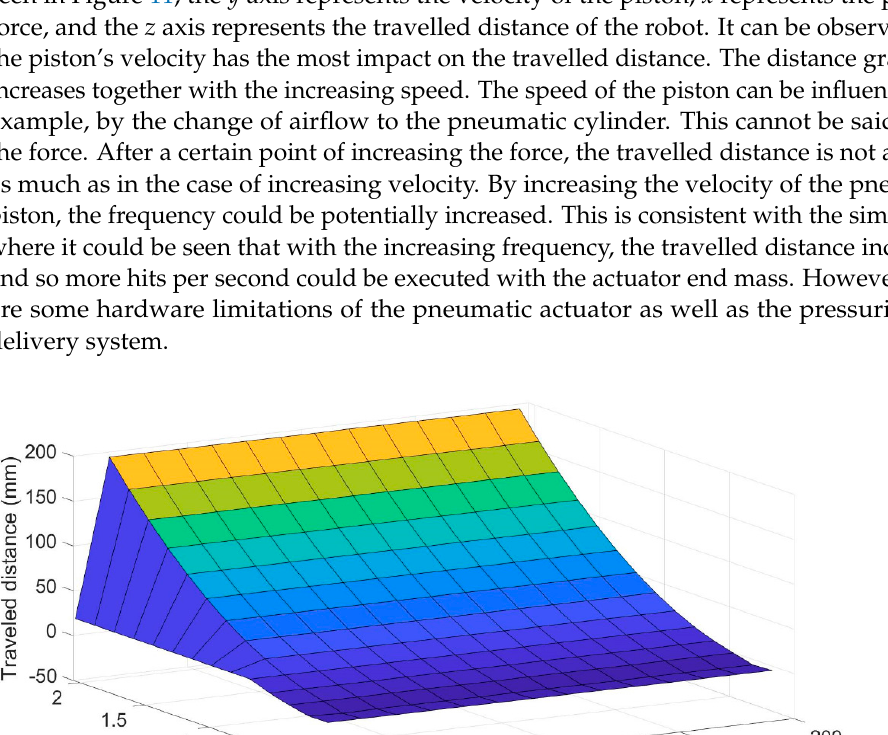
Figure 10 . Correlation between the magnitude of the friction forces, the direction of the friction forces, and the distance travelled .